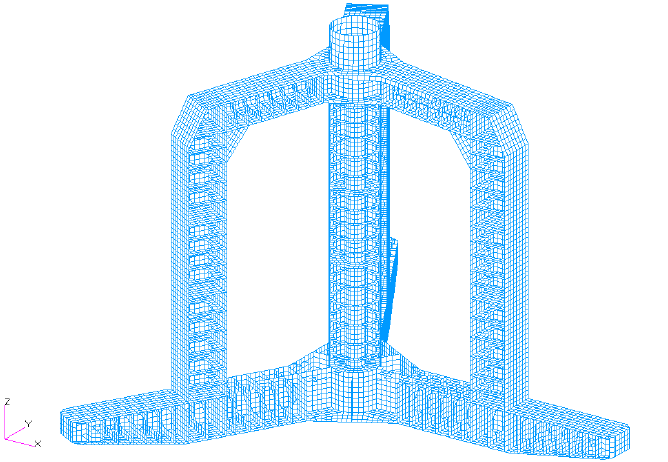
Figure 8. FE model of the WindStar TLP hull, showing both the outer shell and inner structure.